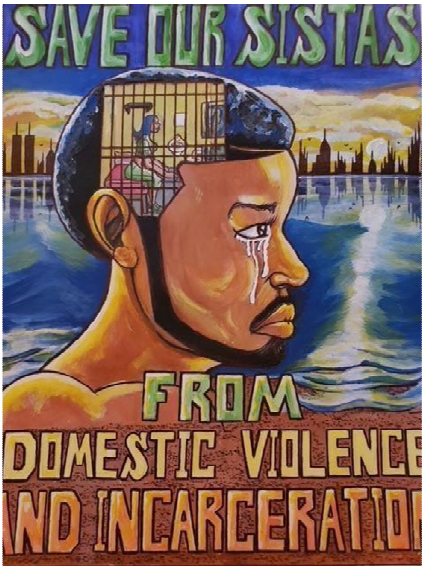
Figure 2. Artwork by Bruce Bryant. Sent as a gift from a men’s facility upstate to Sharon White- Harrigan after she appeared on Cable television to discuss the DVSJA.